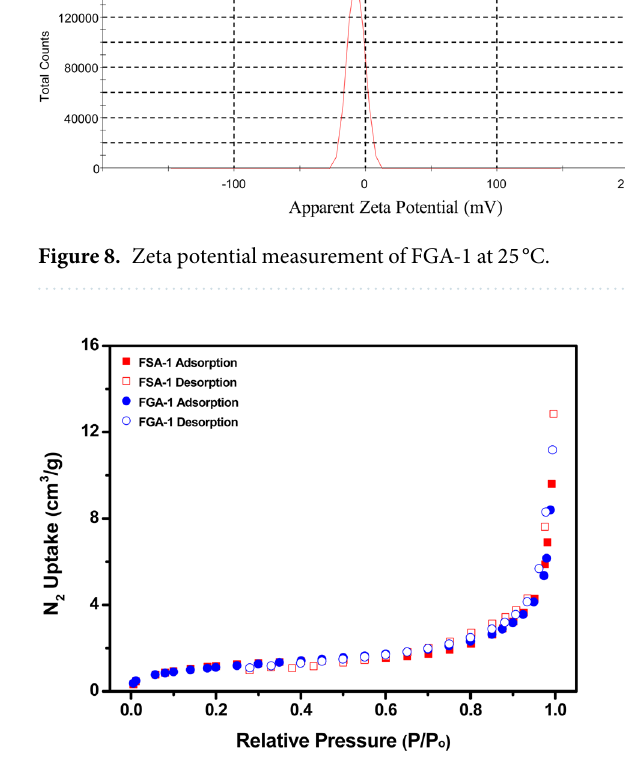
Figure 9. N 2 gas isotherms of FSA-1 and FGA-1 measured at 77